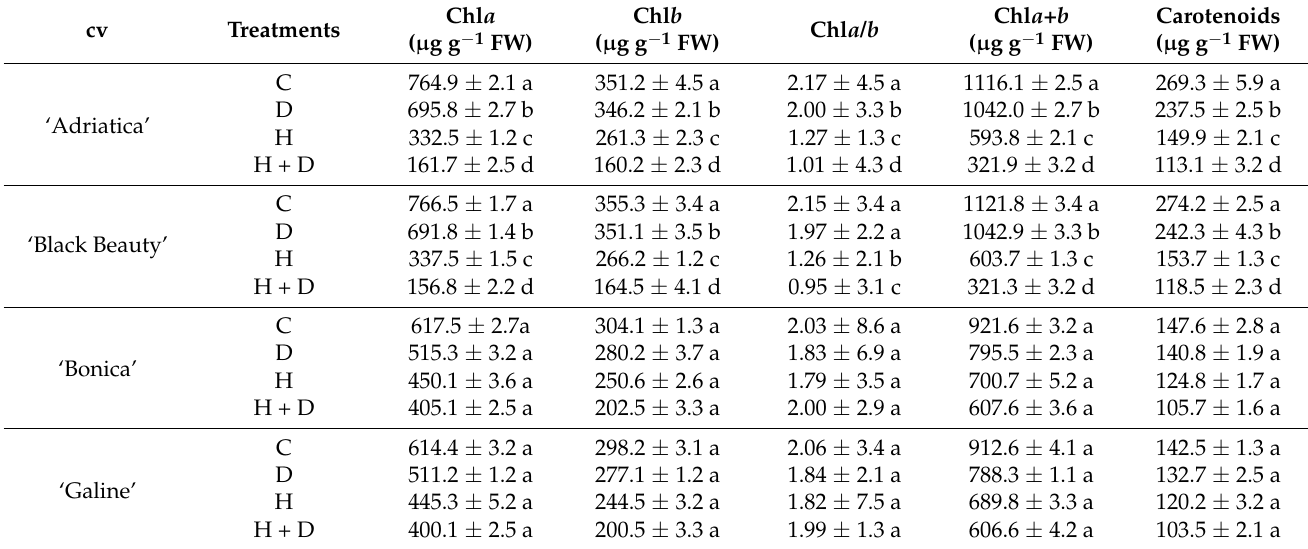
Table 3. Effect of Drought, heat, and combined drought and heat on chlorophyll a (Chl a ), chlorophyll b (Chl b ), Chl a/b , total chlorophyll (Chl a+b ), and carotenoids in leaves of the eggplant cultivars after 30 days of stress